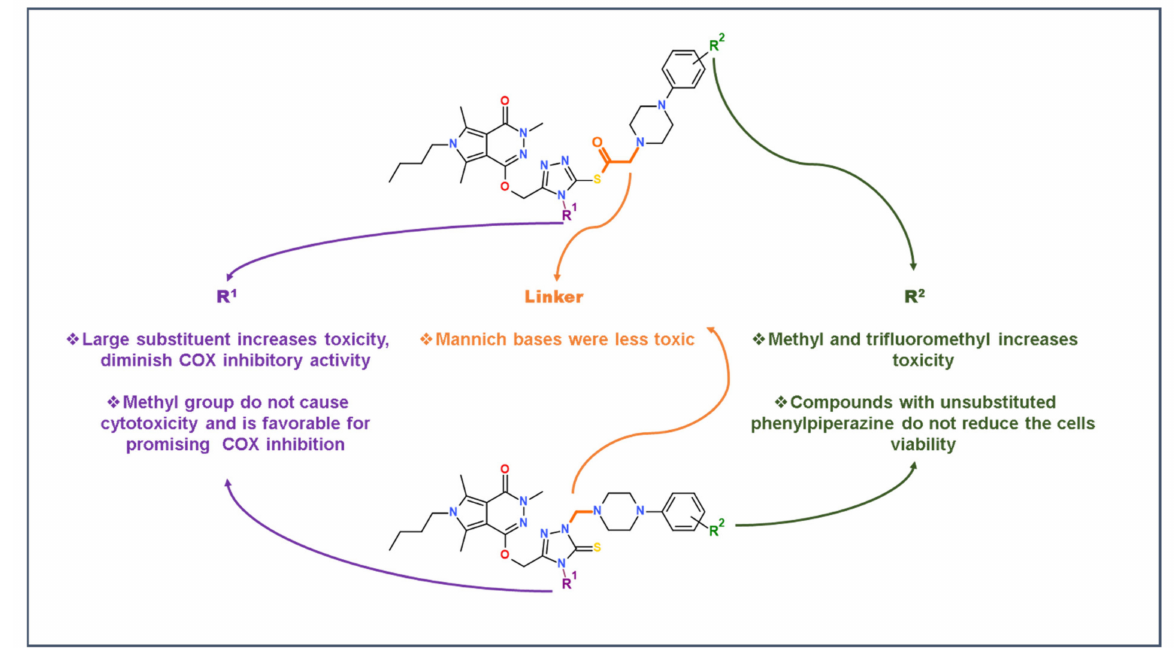
Figure 8. The structure-activity relationships in the group of investigated